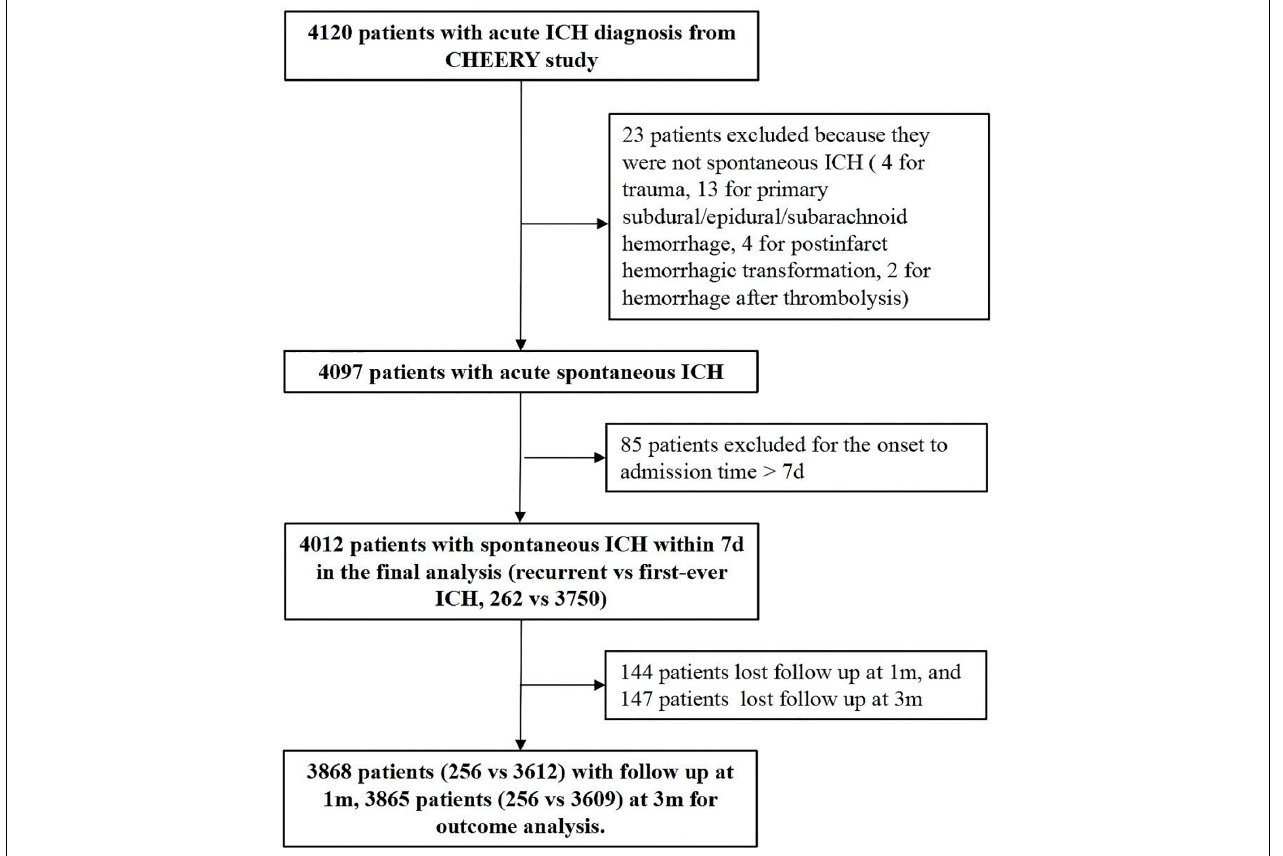
FIGURE 1 | The patient enrollment